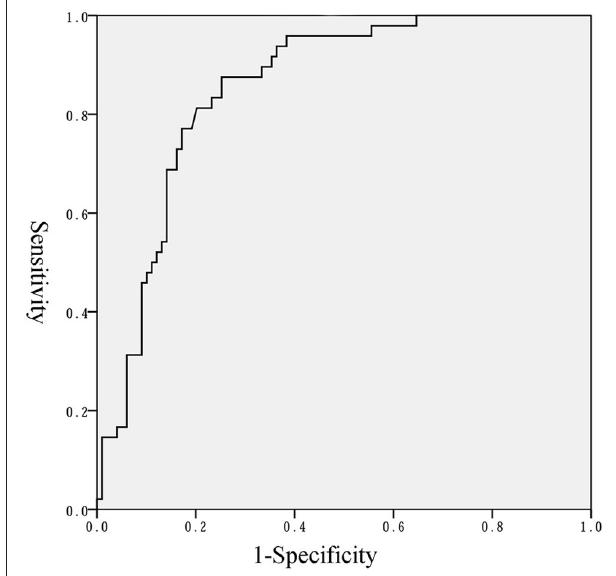
FIGURE 4 | Receiver operator characteristics curve of NT-proBNP level to predict moderate/severe BPD or